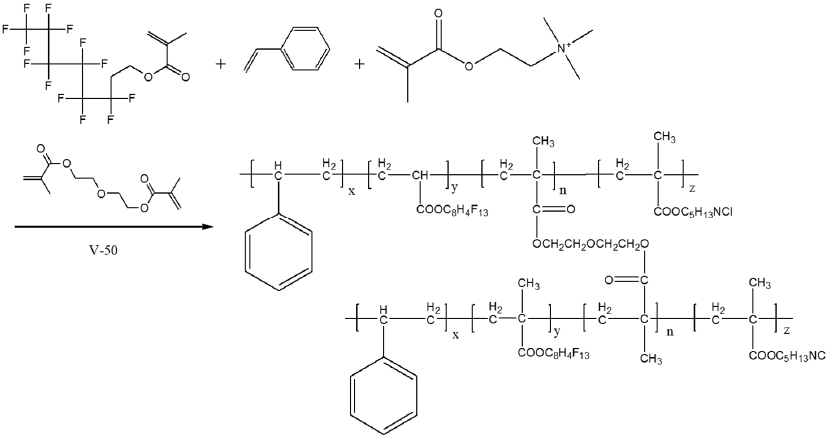
Figure 2. Schematic diagram of the synthesis of the fluorinated nano ‐ emulsion.